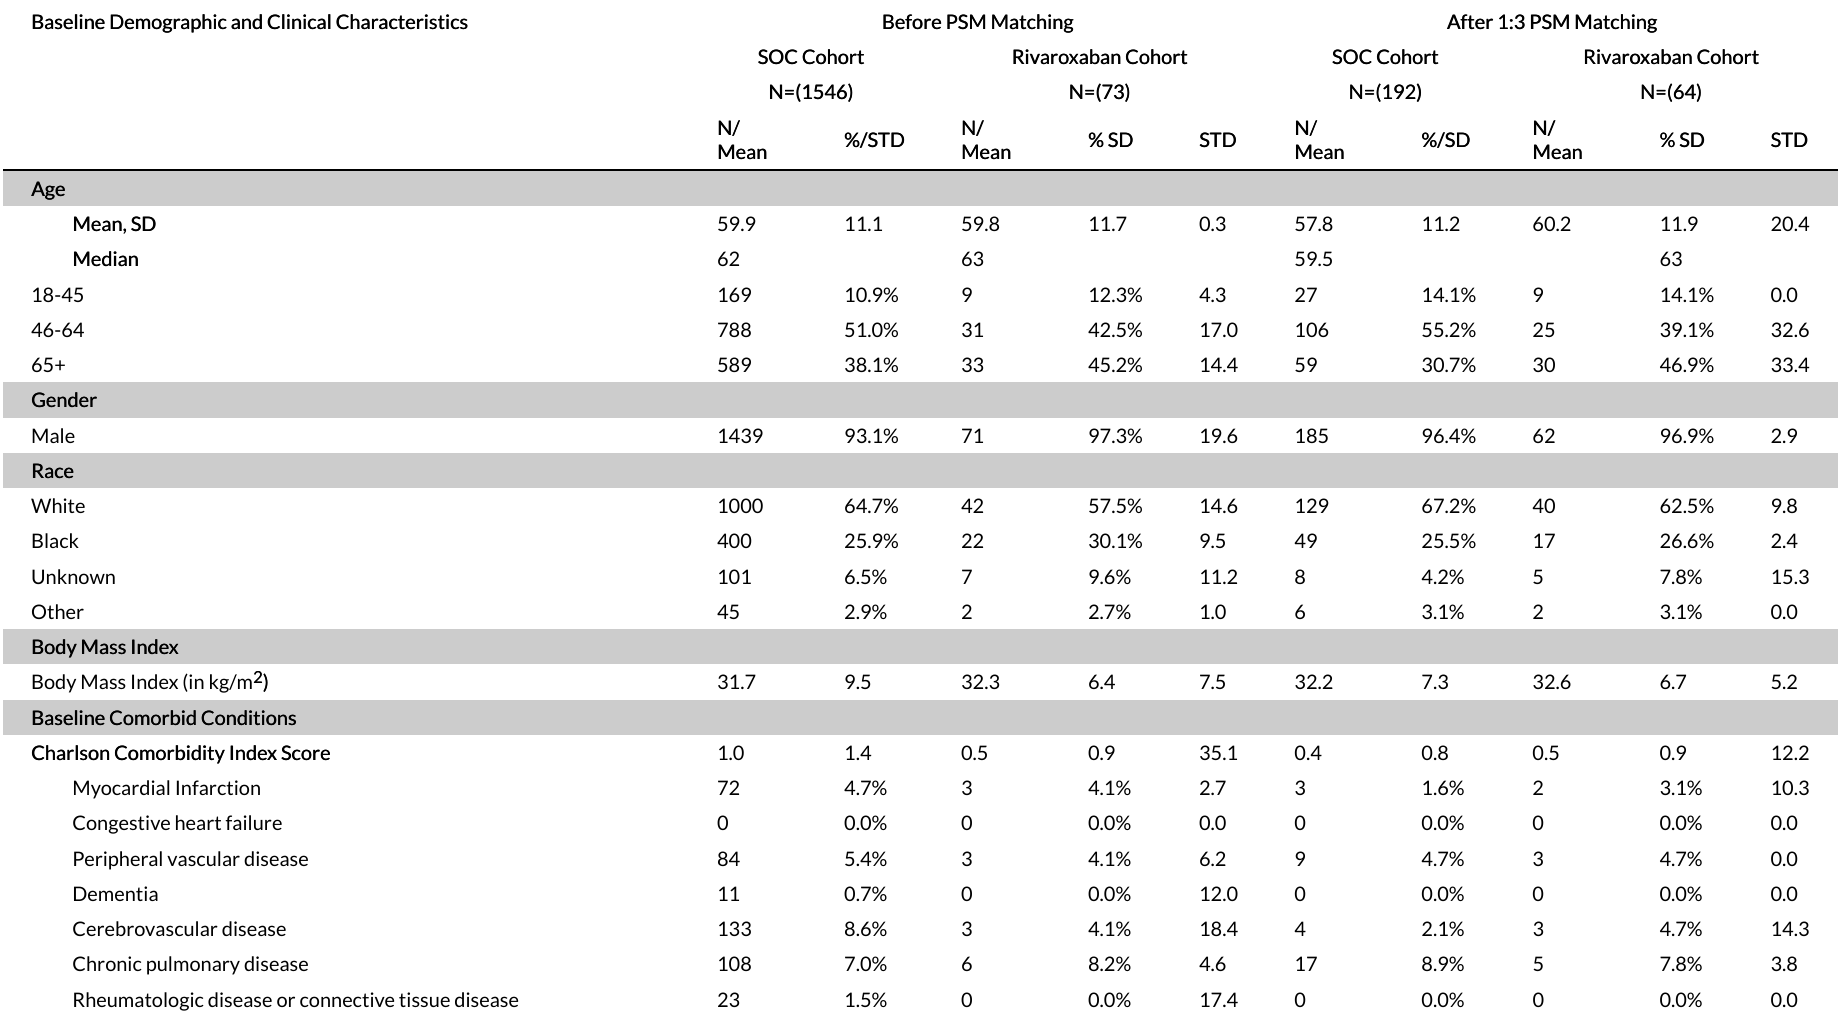
TTable 1. Demographic and Clinical Characable 1. Demographic and Clinical Characteristics of LRPE Pteristics of LRPE Patients prescribed SOC and Rivaroatients prescribed SOC and Rivaroxaban -Baseline and Indexaban -Baseline and Index hospitalizationx